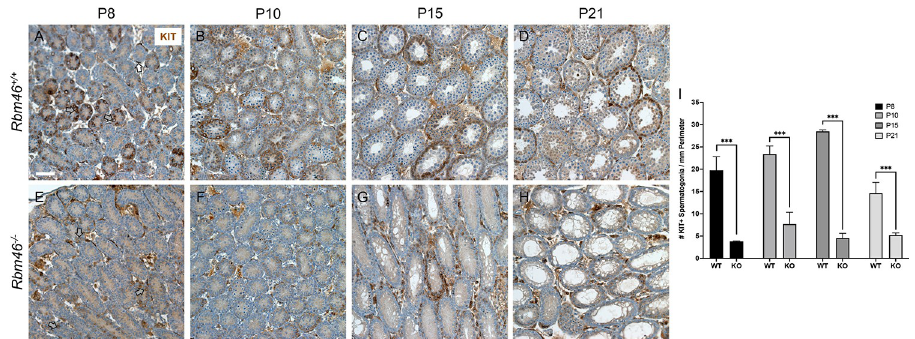
Fig 4. KIT+ differentiating spermatogonia were reduced dramatically in developing Rbm46 -/- testes. ( A-D ) Darkly staining KIT+ (brown) spermatogonia (gray arrows, A ) were numerous in Rbm46 +/+ testes. KIT+ interstitial cells are indicated with white arrows. ( E-H ) At P8, there are scattered faintly staining KIT+ spermatogonia (gray arrows, E ), and fewer are seen afterwards, from P10 ( F ) through P15 ( G ) and then at P21 ( H ). ( I ) Quantitation of KIT + spermatogonia at each age. Scale bar = 50 μ m. Triple asterisks indicate statistical significance at P < 0.001.